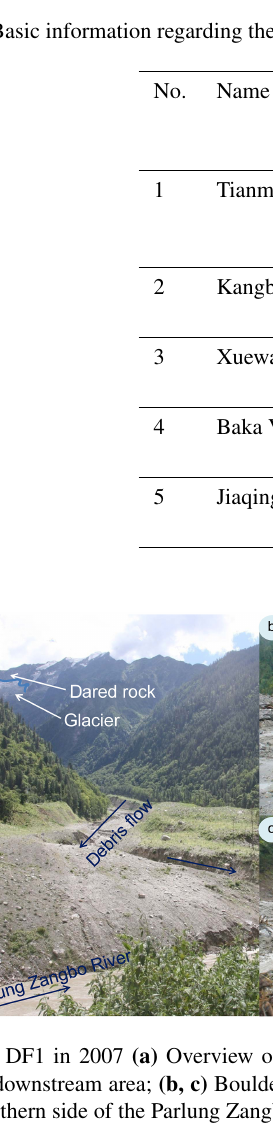
Figure 4. Particle size distributions of the glacial tills and debris flow